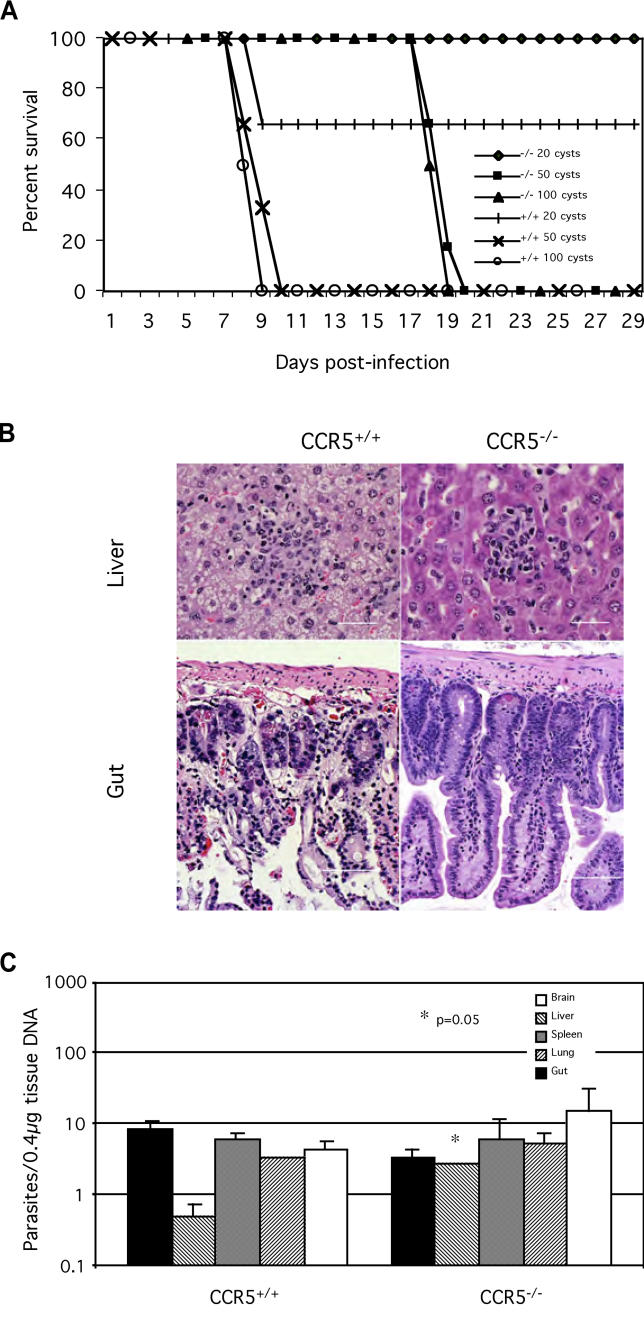
Survival, Histopathology, and Parasite Load of CCR5−/− and CCR5+/+ Mice in a C57BL/6 Background following Infection with Different Doses of T. gondii
(A) Survival. Female CCR5−/− mice (5–7 wk old) and age-matched CCR5+/+ wild-type controls in the C57BL/6 background were challenged perorally with the cysts of the 76K strain of T. gondii. The animals were monitored for survival on a daily basis. There were six animals per group and the experiment was performed three times with similar results.(B) Histopathology. Photomicrographs of hematoxylin and eosin-stained liver and ileum of small bowel isolated from infected CCR5−/− and CCR5+/+ mice. Liver of infected CCR5+/+ mouse reveals hepatocytes with extensive fatty degeneration. A nodule of inflammatory cells is seen in the center of the field, composed of lymphocytes and granulocytes. Hepatocyte morphology is preserved in liver of an infected CCR5−/− mouse. A small nodule of inflammatory cells, largely composed of lymphocytes, is seen in the center of the field. Ileum of an infected CCR5+/+ mouse contains extensive epithelial necrosis and ulceration. Dilated blood vessels with hemorrhage are evident. The epithelial architecture is preserved in ileum of infected CCR5−/− mouse. Bars: ileum, 100 μm; liver, 50 μm.(C) Level of parasite DNA. Groups of CCR5−/− and CCR5+/+ mice on the C57BL/6 background were infected perorally with 20 cysts of T. gondii. At day 7 PI, small intestine, liver, spleen, lung, and brain from both CCR5−/− and wild-type mice (three mice per group) were collected and the level of parasite load in the tissues was determined by competitive DNA PCR. The experiment was performed twice with similar results.